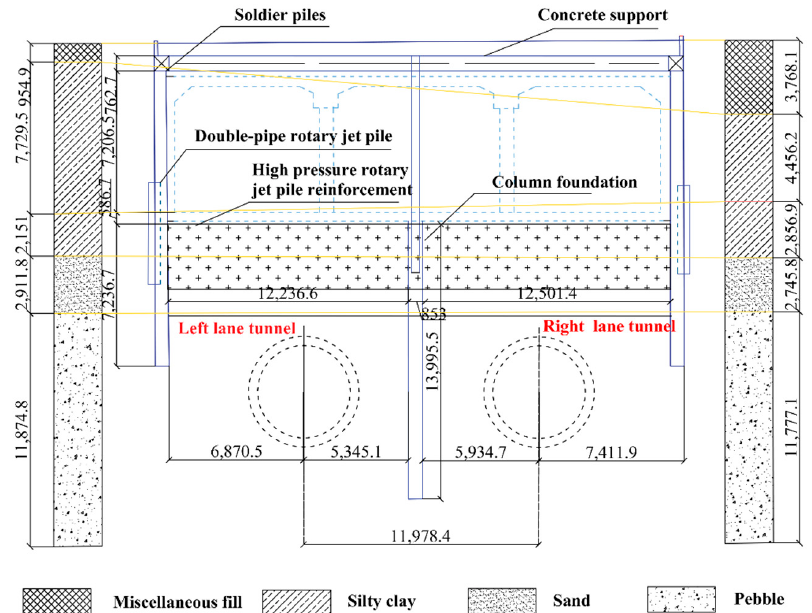
Figure 8. Geological section of the envelop enclosure of the comprehensive underground utilization project of Guangxi University of Finance and Economics.